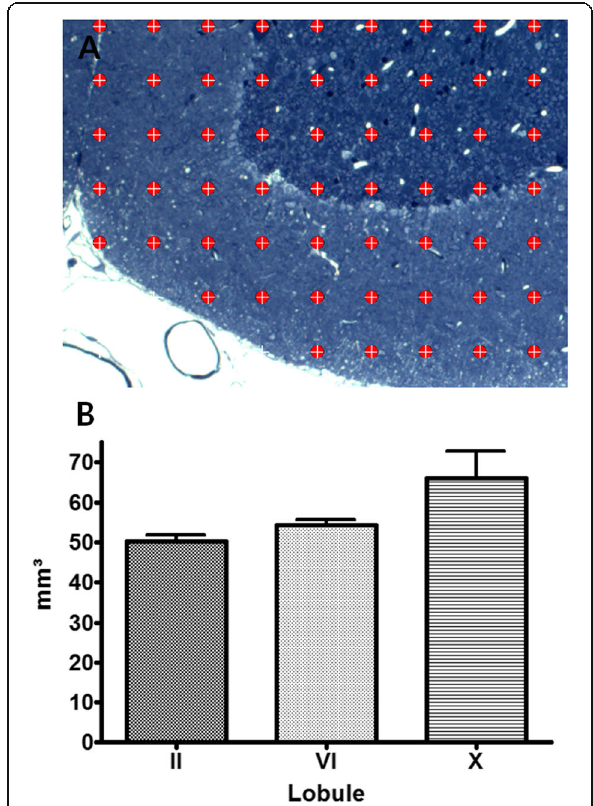
Fig. 2 Cavalieri ’ s estimation of volume in cerebellum vermis. a Image is checked by overlaying a rectangular lattice of point on the area of each lobule. Grid scale is 50 μ m, × 100, b Result from the